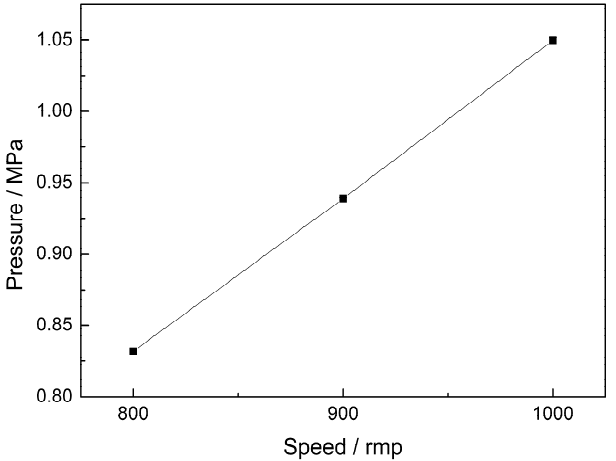
Figure 8. Maximum oil film pressure at different speeds.